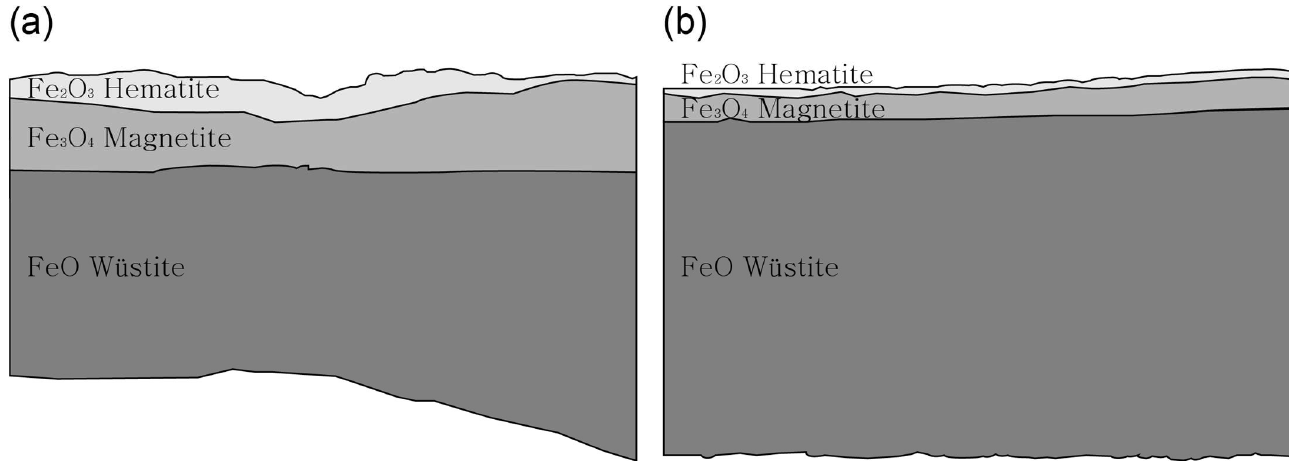
Figure 15. Structure of the flake hammer scale samples: ( a ) flake hammer scale (No. 3), ( b ) flake hammer scale (No. 4).